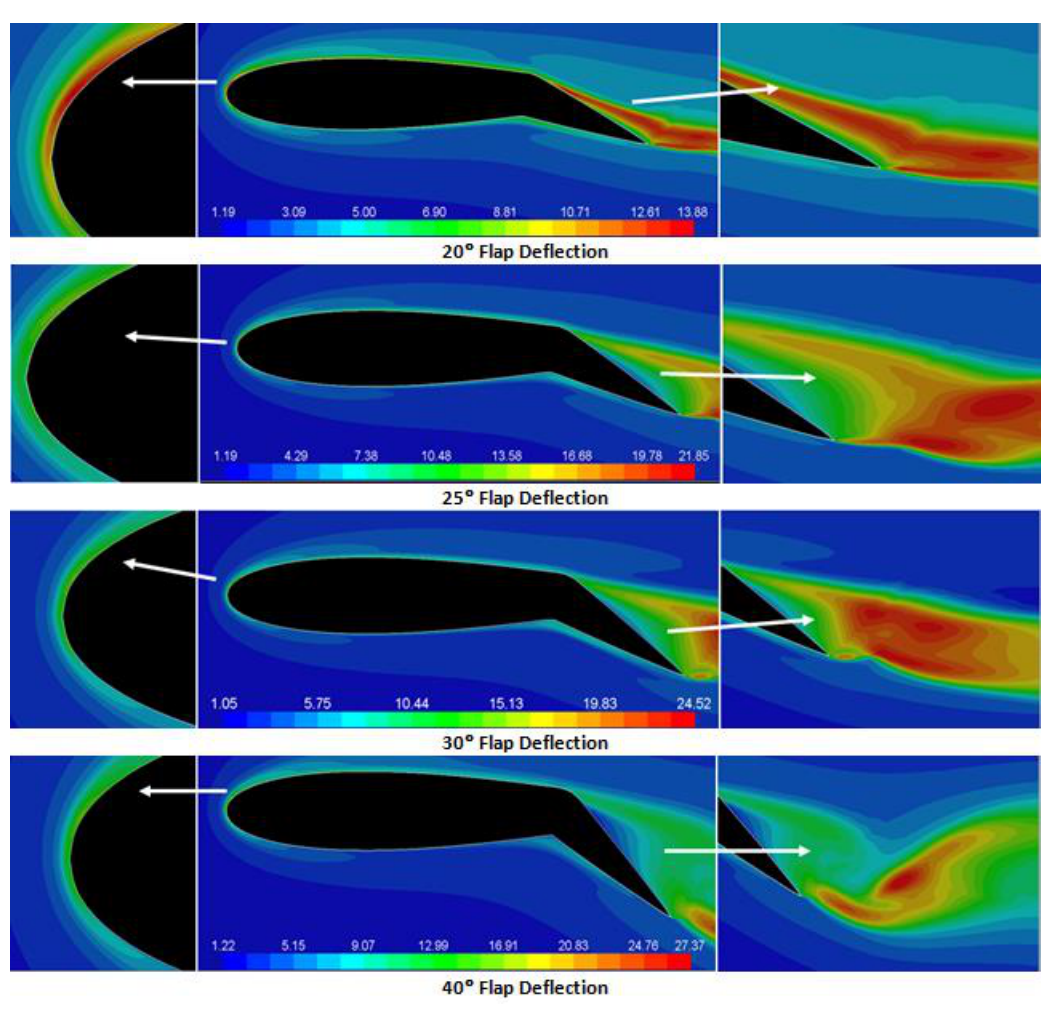
Figure 21. Contours of turbulence intensity (%) around the flapped airfoil at AoA = 0° and various flap deflections.